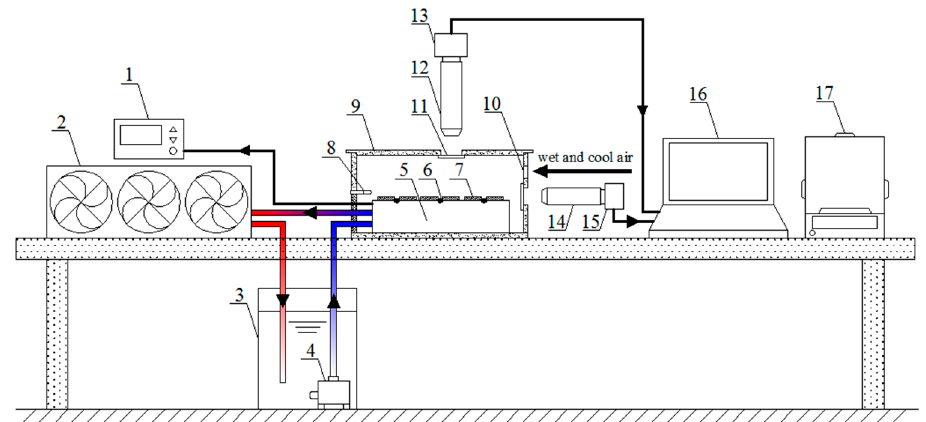
Figure 3. Schematic of the experimental testing rig. 1: Temperature controller; 2: Air-cooled radiator;